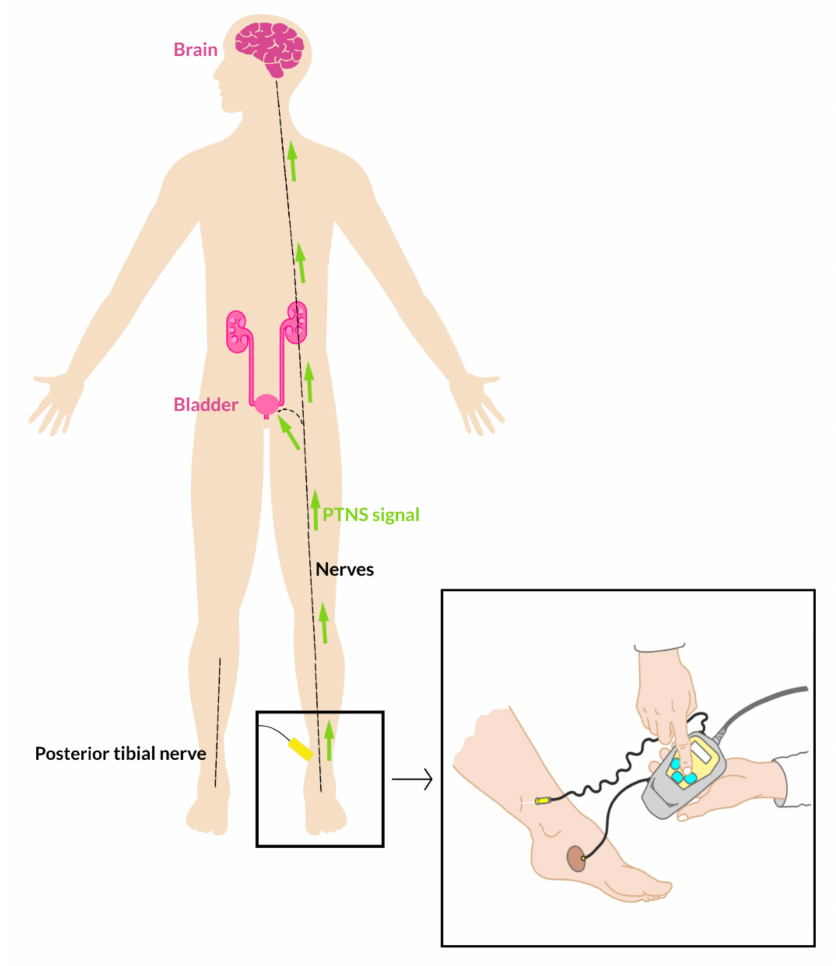
Figure 1. Schematic view of posterior tibial nerve